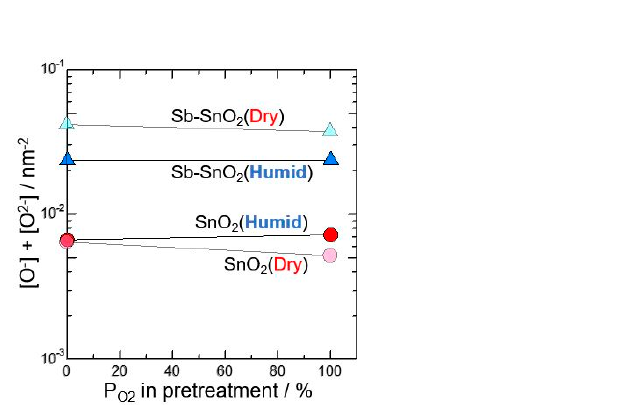
Figure 3. Total amounts of [O 2 − ] and [O − ] against oxygen partial pressure in pretreatment (measured in dry and wet